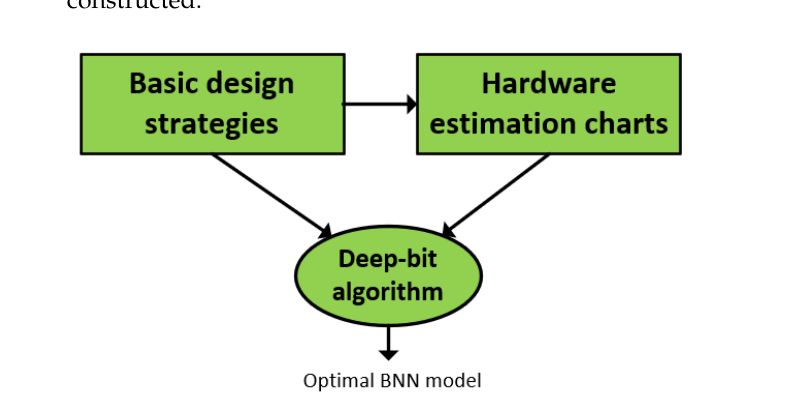
Figure 3. A generic block diagram for the architecture searching